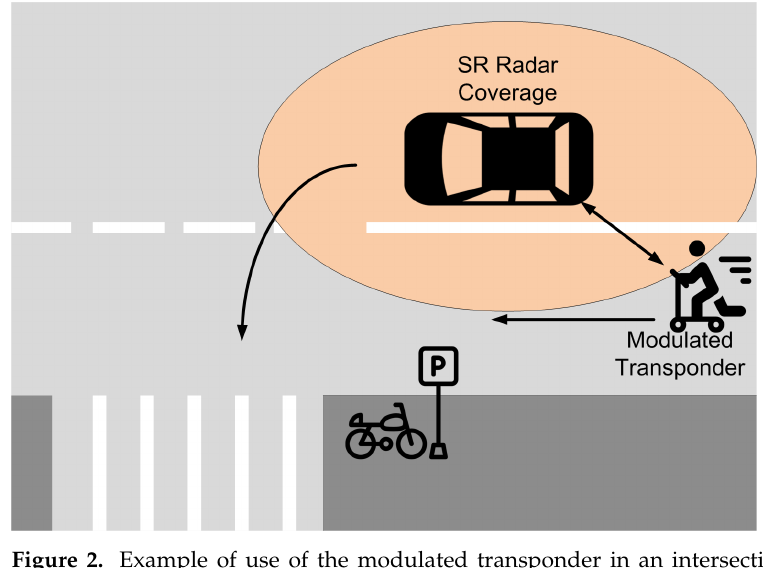
Figure 2. Example of use of the modulated transponder in an intersection of a vehicle with a bicycle lane.